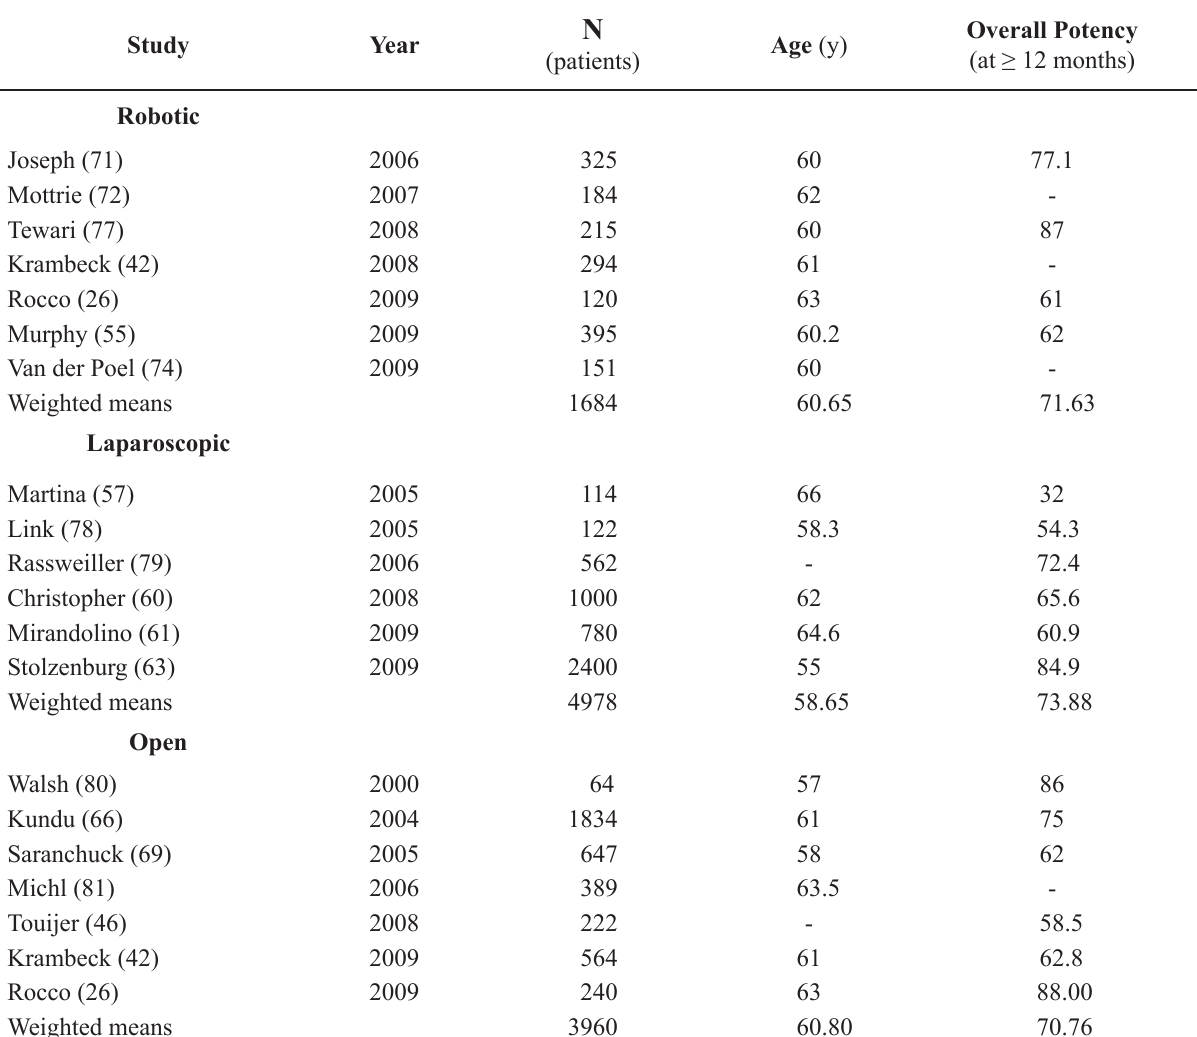
Table 4 – potency of RRP, LRP and RALP